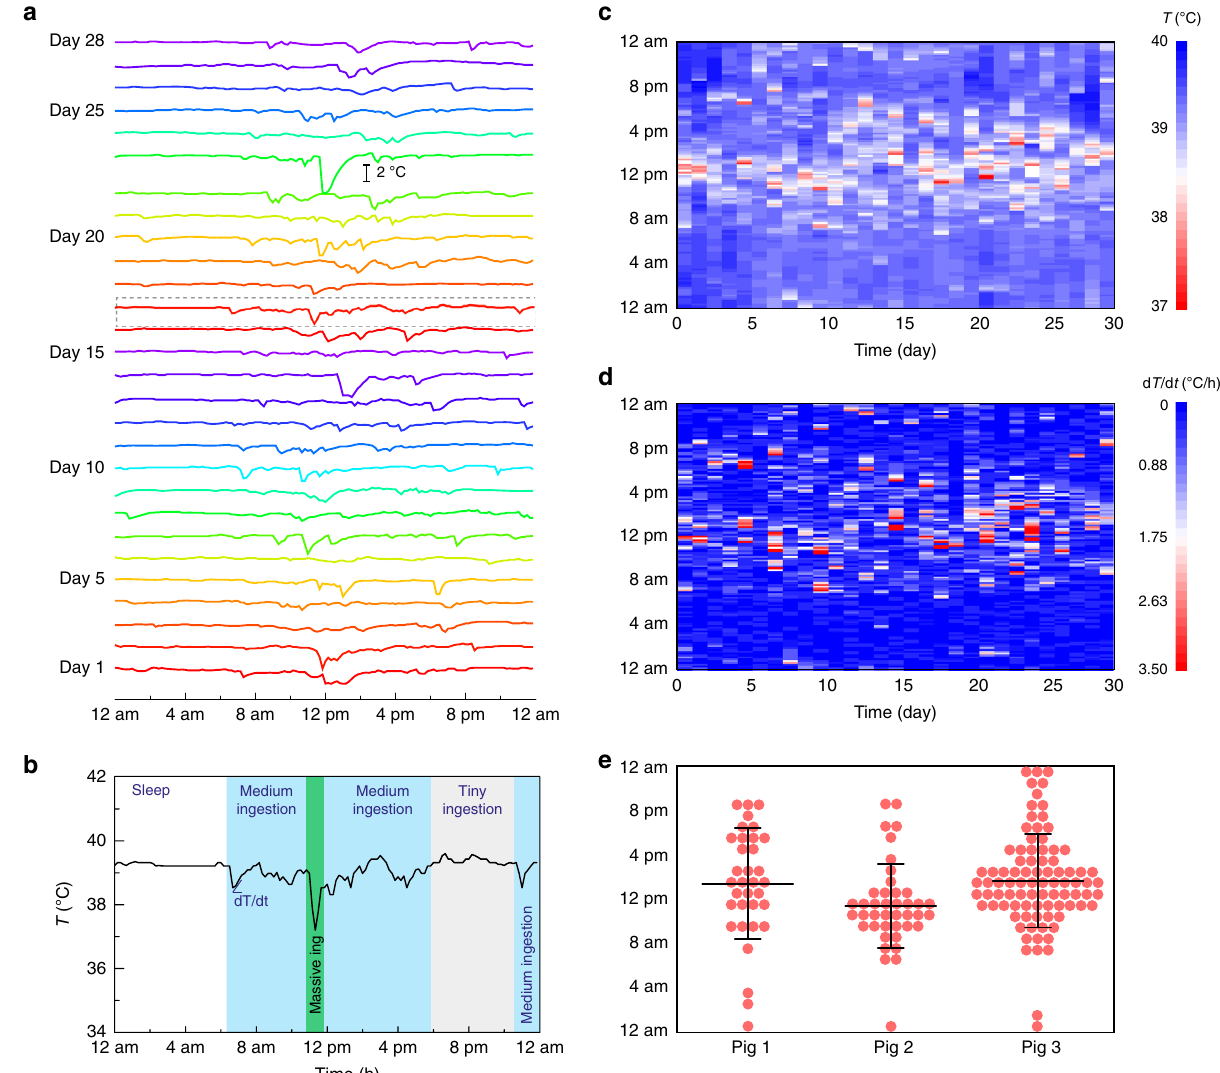
Fig. 5 Analysis on the prolonged porcine gastric temperature pro fi le measured. a The long-term measured gastric temperature in Fig. 4f are replotted on a daily basis. b On a single day (day 17), the temperature pro fi le is divided into different phases with different ingestion activities based on the degree of fl uctuations. c The heatmap of the temperature ( T ) measured by hydrogel device over 29 days. d The heatmap of the absolute temperature derivative (| dT/dt |) measured by hydrogel device over 29 days. e The time slots (1 h) with food intake (if any | dT/dt | > 1.75 during the time slot) are marked as events for different pigs. Data represent the mean ± s.d. N = 34 events for pig 1 in 9 days, N = 41 events for pig 2 in 13 days, and N = 88 events for pig 3 in 29 days NATURE COMMUNICATIONS| (2019) 10:493